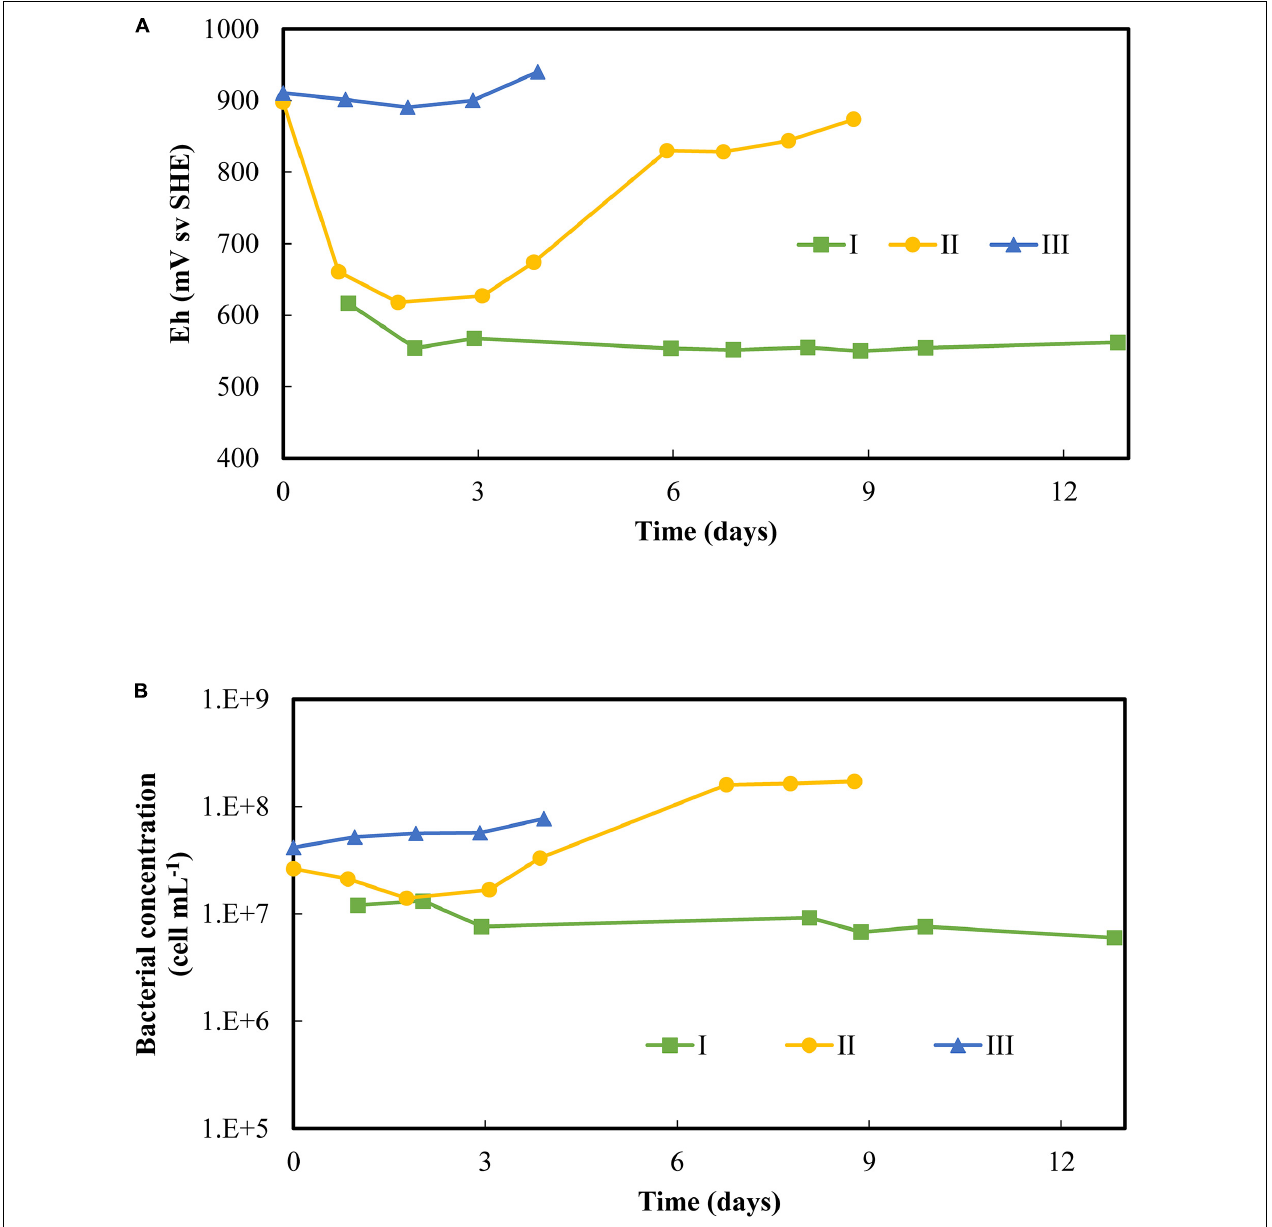
FIGURE 4 | Follow-up of (A) redox potential and (B) bacterial concentration overtime during the startup of continuous flow PCB bioleaching experiments in 2.2 L-STRs. Three scenarios of the startup were tested: I was only inoculated with the non-adapted culture; II performed a batch test on the adapted culture before starting the continuous flow process; III performed two successive batch subcultures on the adapted culture prior to the continuous flow process. Conditions of continuous flow bioleaching were set at 48 h of HRT and 1% (w/v)